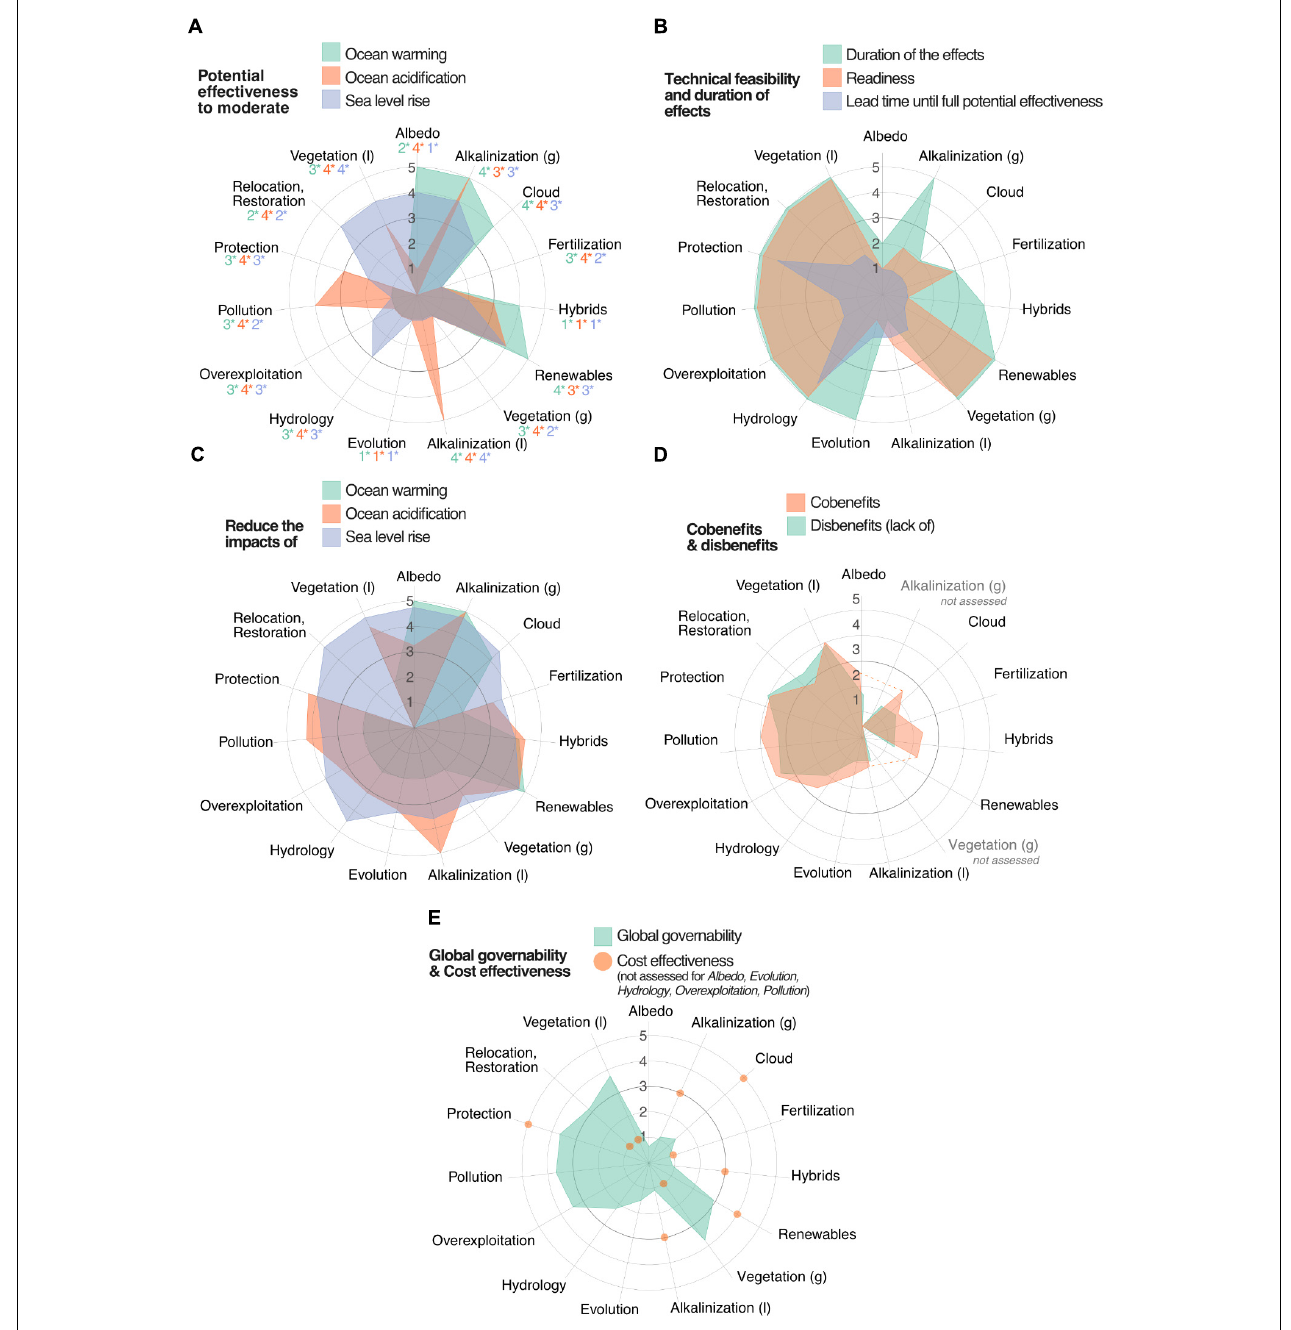
FIGURE 4 | Assessment of ocean-based measures to address key ocean drivers. Scores 1 to 5: very low, low, moderate (thicker circle), high, and very high. Confidence levels of the potential effectiveness to moderate ocean warming, ocean acidification, and sea-level rise are shown in panel (A) (1 ∗ to 5 ∗ ; very low, low, moderate, high, very high; see section “SM2.1” of the Supplementary Materials ). Details on the assessment can be found in section “SM3” of the Supplementary Materials